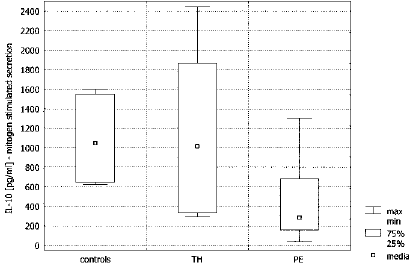
FIG. 8. Comparison of IFN g PHA-timulated secretion in healthy pregnant women (controls) ( n = 11), and pregnant women with transient hypertension (TH) ( n = 17) and pre- eclampsia (PE) ( n = 21). Statistically significant are the differences between controls and PE ( p < 0.0002) and between TH and PE ( p <